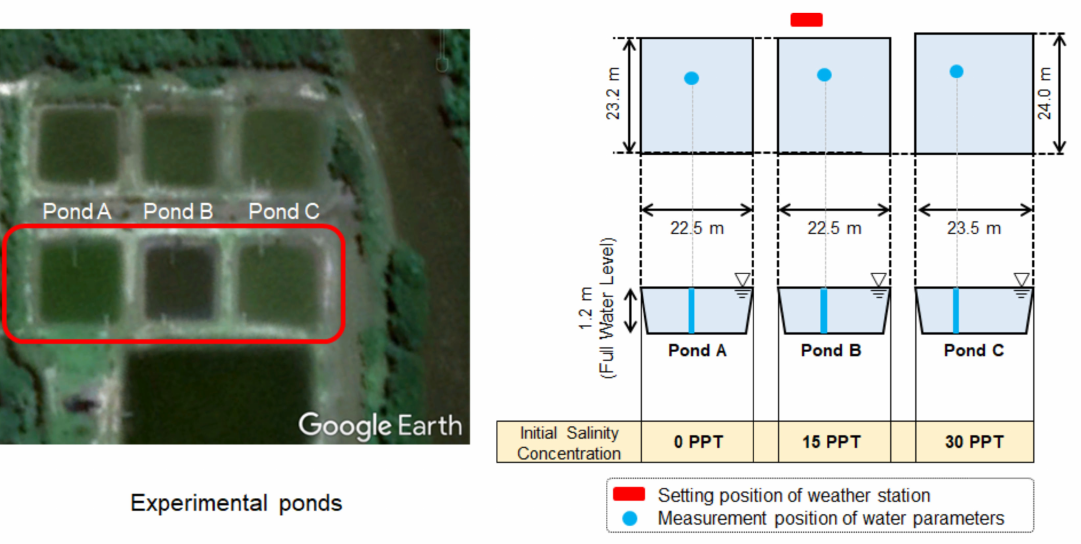
Figure 2. Schematic of the experimental